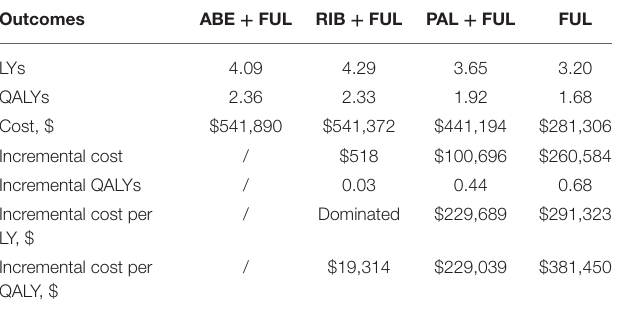
TABLE 2 | Base-case results.